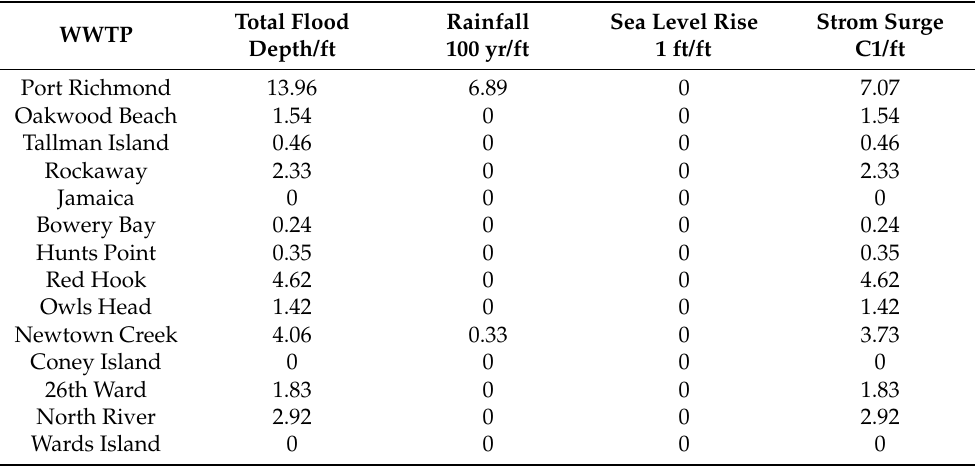
Table 7. Estimation of the potential magnitude of flood depth due to the compounded effect of high-intensity rainfall, sea level rise, and storm